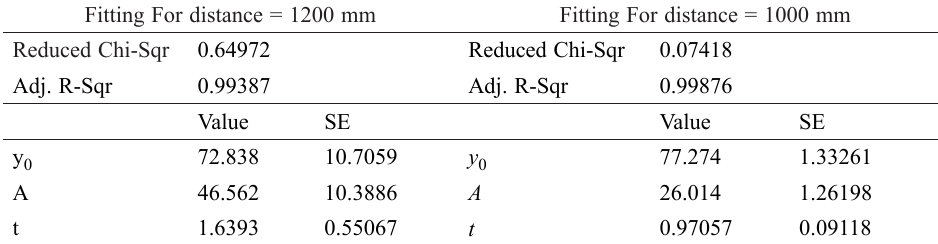
Table 1. Detailed fitting information for Figure 6 (